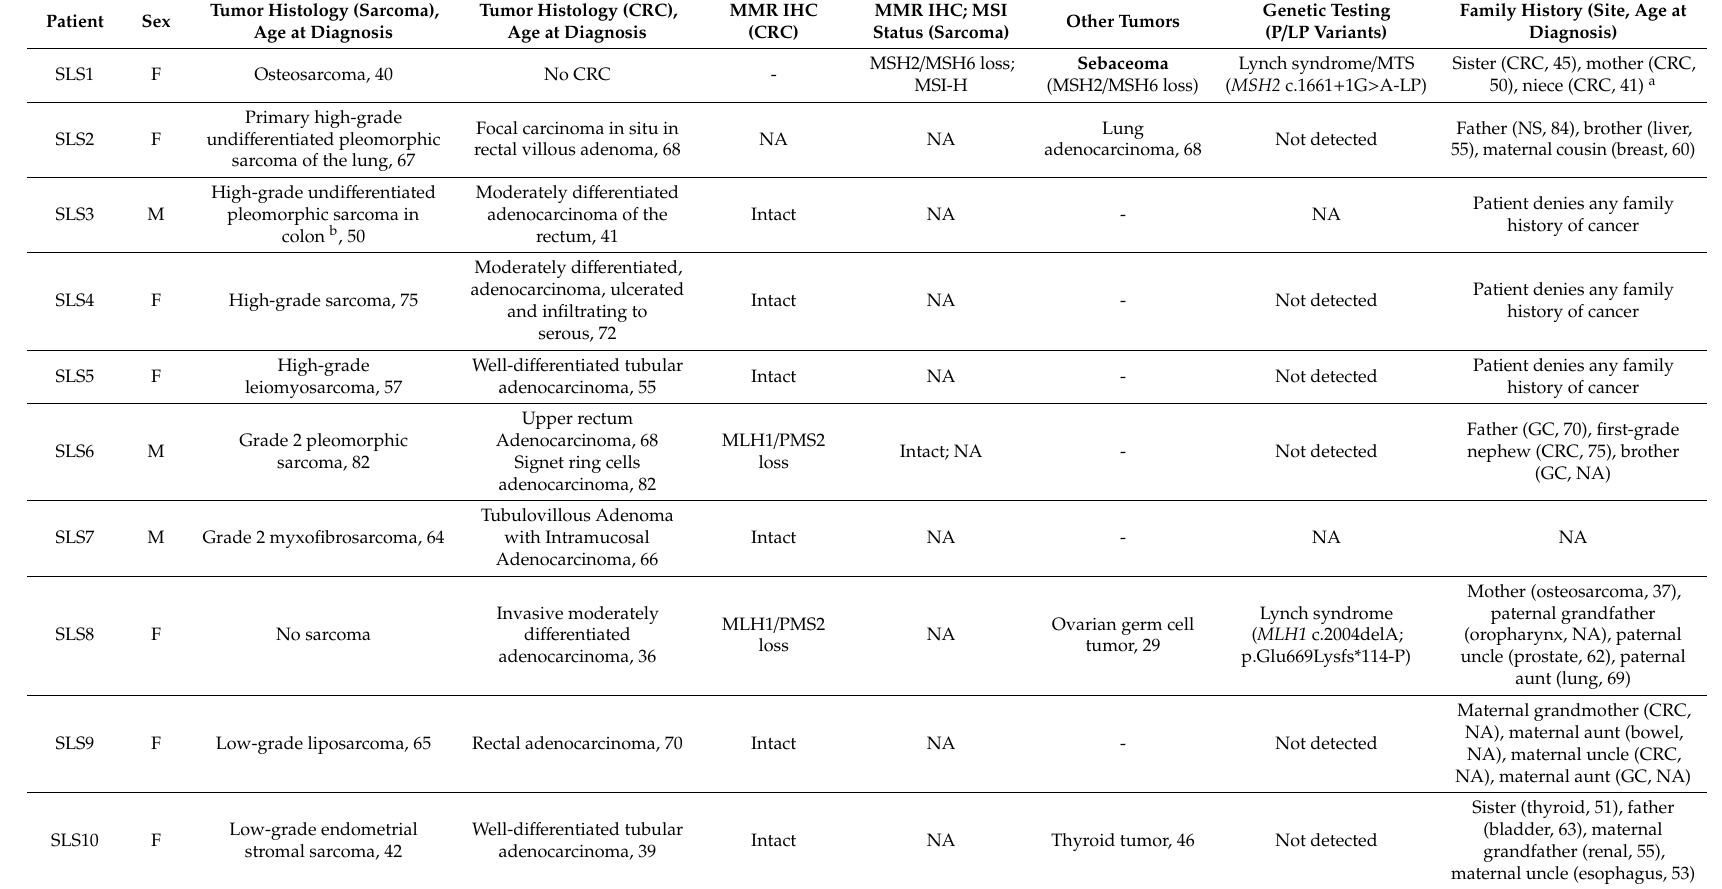
Table 1. Clinical and molecular data from patients diagnosed with sarcoma and tumors from the LS